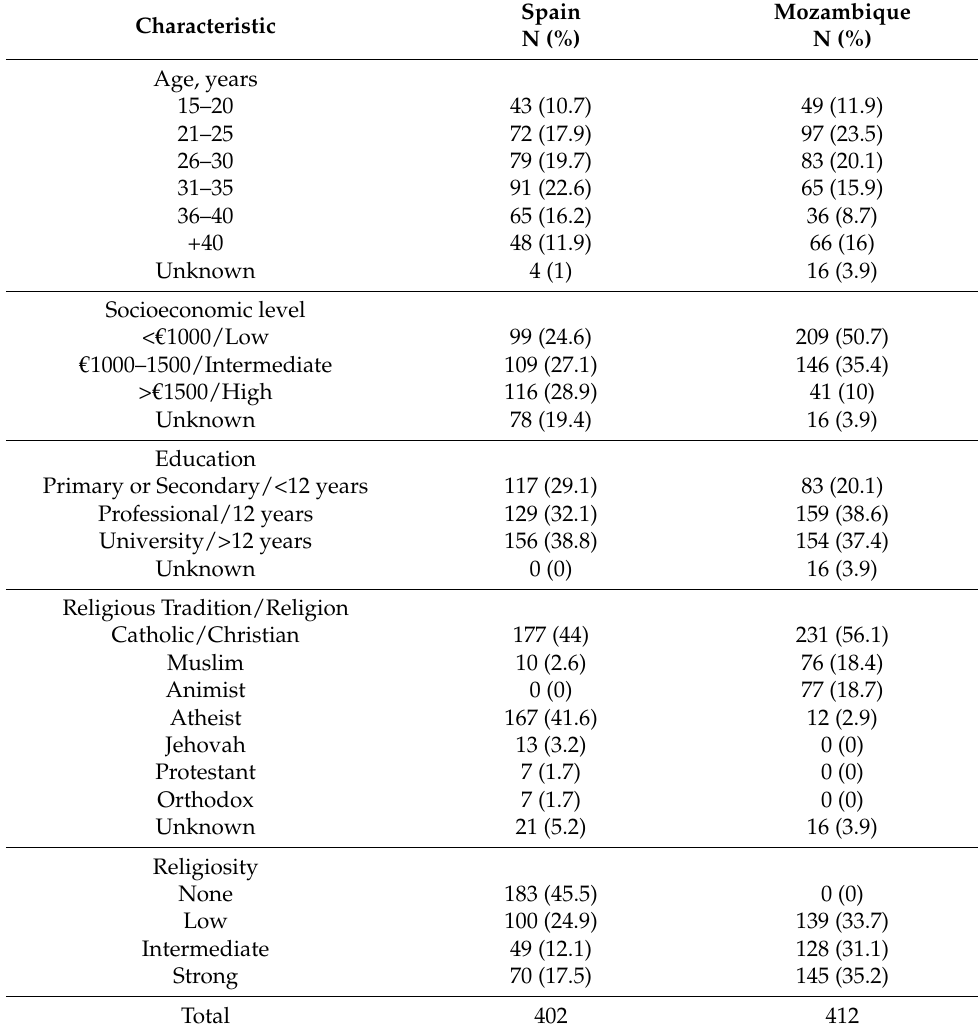
Table 2. Table 2. Sociodemographic characteristics of the samples of Spain and Mozambique.